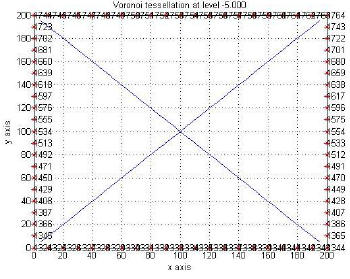
Figure 26. Voronoi tesselletion (level -5.000) The Delaunay triangulation is also applied to points that belong to a different level. This is done in order to create a rough 3D